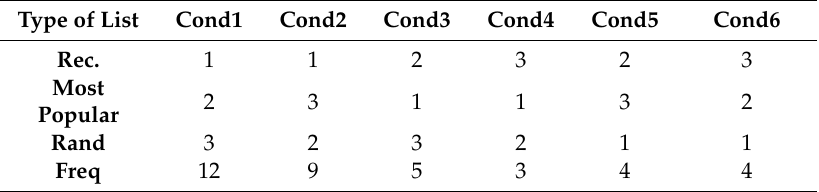
Table 1. Position of the list types under each of the six experimental conditions. Type of List Cond1 Cond2 Cond3